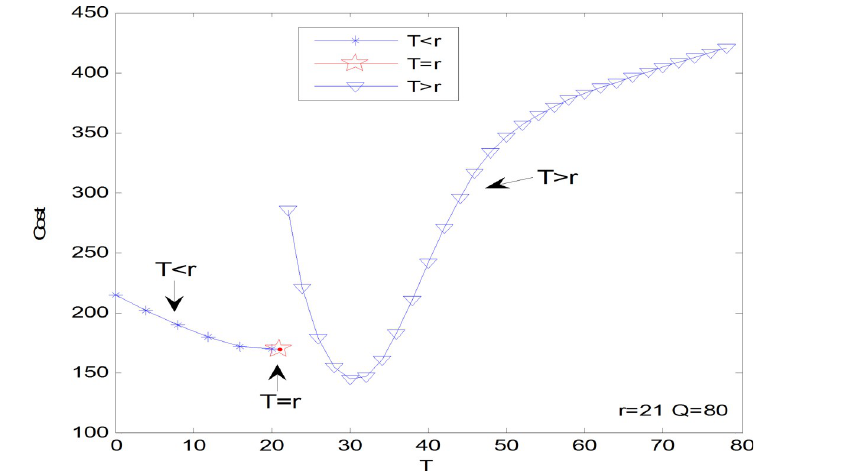
Fig 5. The inventory cost as a function of T